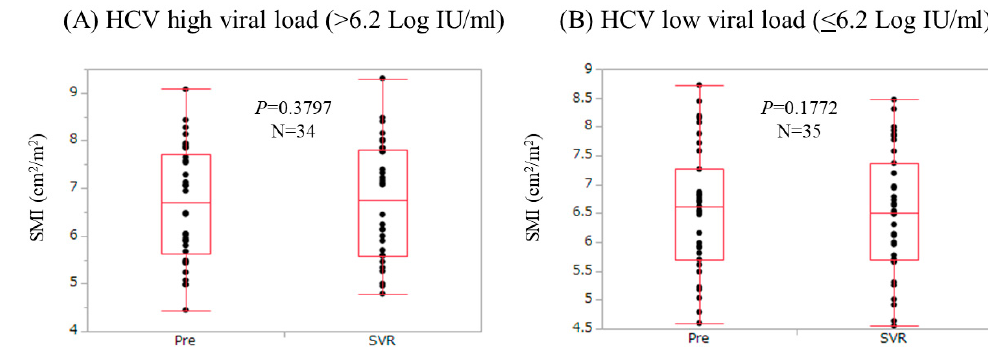
Figure 4. Changes in SMI according to HCV viral load. Patients with baseline HCV viral load >6.2 log IU/mL (the median value in our cohort) were defined as the high HCV viral load group ( n = 34), while those with baseline HCV viral load ≤ 6.2 log IU/mL were defined as the low HCV viral load ( n = 35). ( A ) In the high HCV viral load group, SMI at SVR did not significantly increase as compared with baseline levels ( p = 0.3797); ( B ) In the low HCV viral load group, SMI at SVR did not significantly increase as compared with baseline levels ( p = 0.1772).